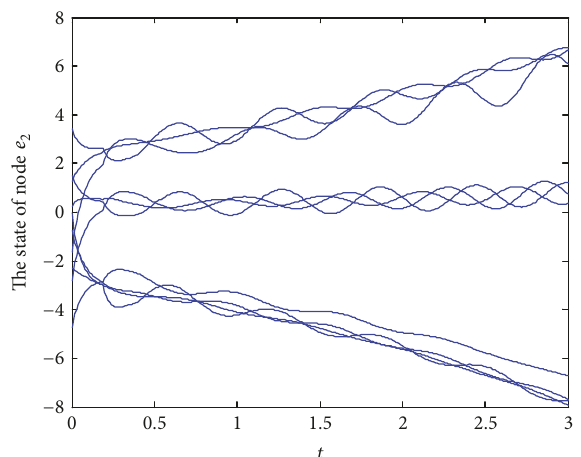
Figure 7: Synchronization error 𝑒 𝑖3 of adding